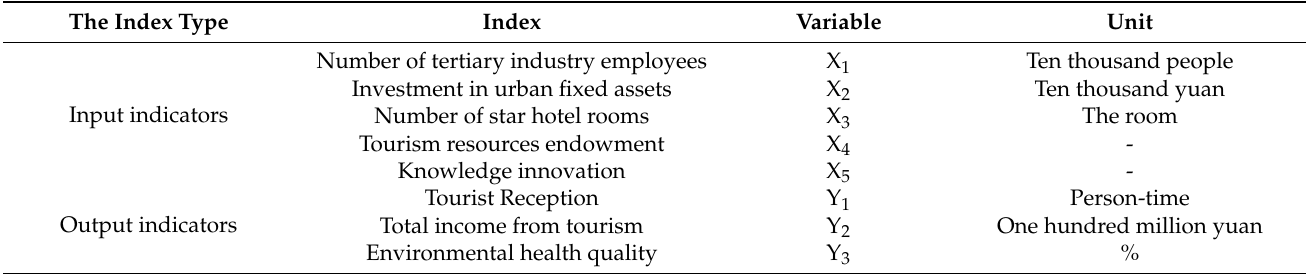
Table 1. Input–output indexes of tourism development efficiency in Hainan